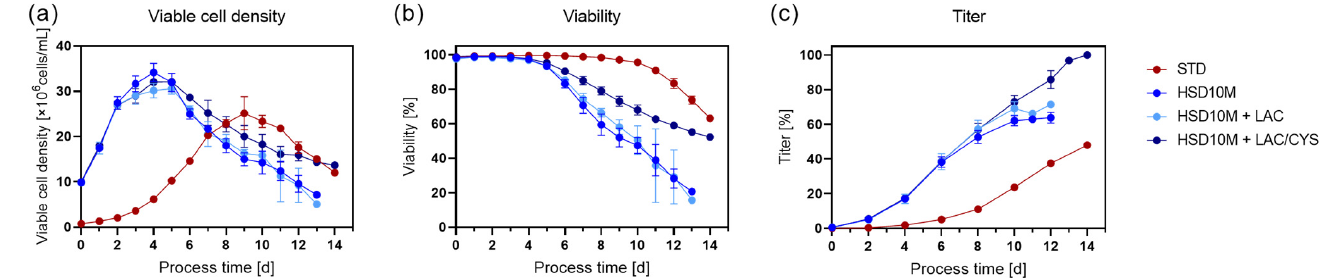
Figure 3. ( a ) Viable cell density, ( b ) viability and ( c ) titer (normalized) over process time (in days) for the investigated processes: standard (2), HSD10M without supplementation (5), HSD10M with LAC supplementation (3) and HSD10M with LAC/CYS (2) supplementation. All experiments were conducted at least twice ( n ≥ 2). The numbers in the brackets show the number of runs which were used for this analysis. STD, standard process with seeding density of 0.7 × 10 6 cells/mL; HSD10M, process with the seeding density 10 × 10 6 cells/mL; +LAC, supplemented with lactate; +LAC/CYS, supplemented with lactate and cysteine.